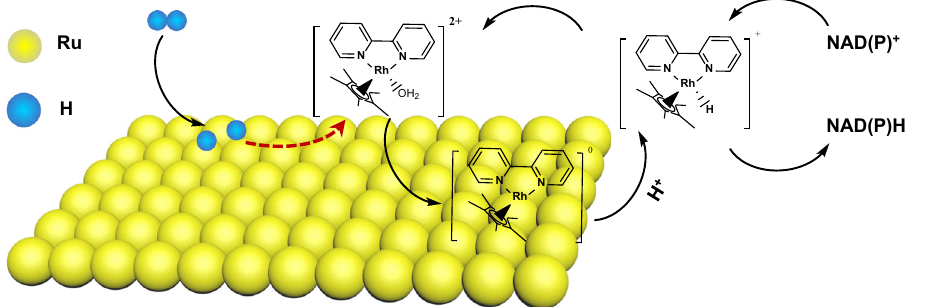
Fig. 3 | Mechanism illustration. Plausible mechanism of NAD(P) + hydrogenation for the homogenous-heterogeneous coupling